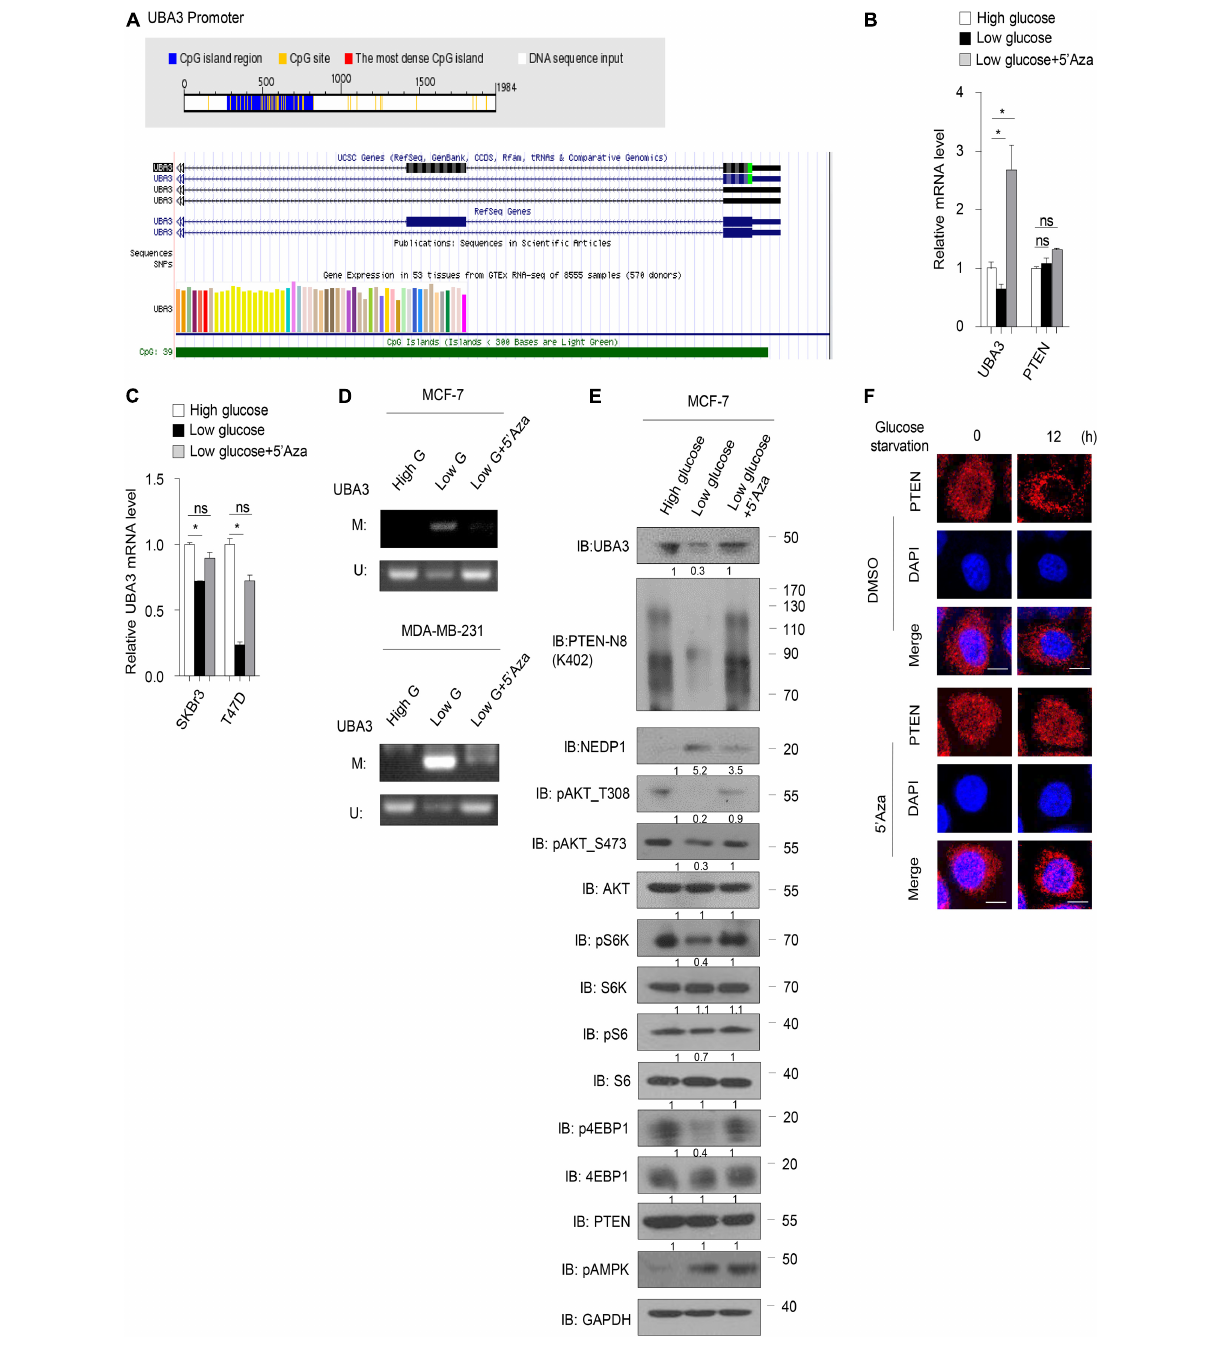
Frontiers in Cell and Developmental Biology |